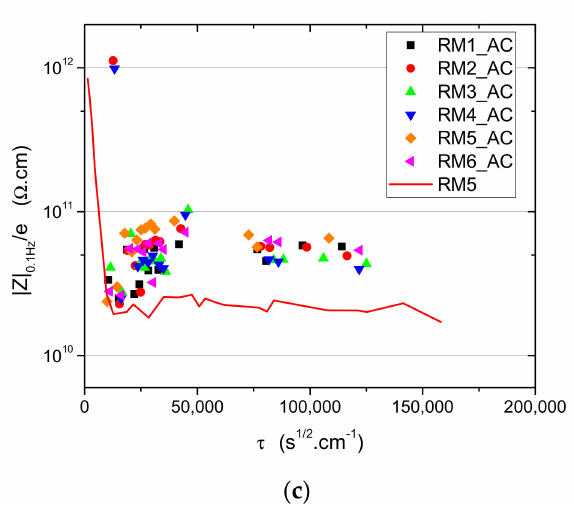
Figure 8. Evolution of | Z | 0.1 Hz /e vs. reduced time for the ageing in alternate cycling for ( a ) ROX system, ( b ) RG system, and ( c ) RM system.